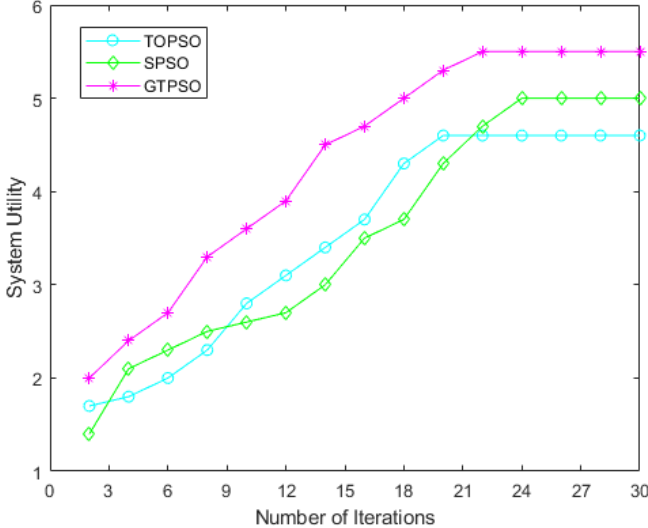
Figure 5. Import of system utility by PSO.